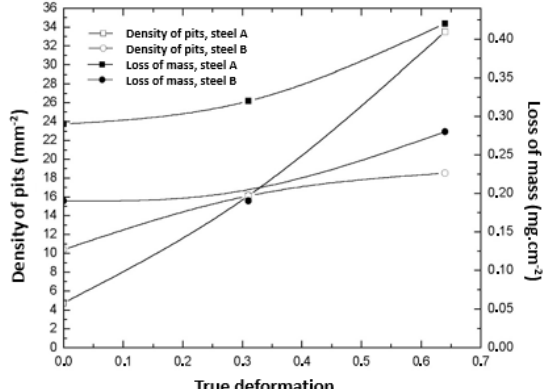
Figure 12. Relationship between the pit density, loss of mass, and deformation for all studied samples.